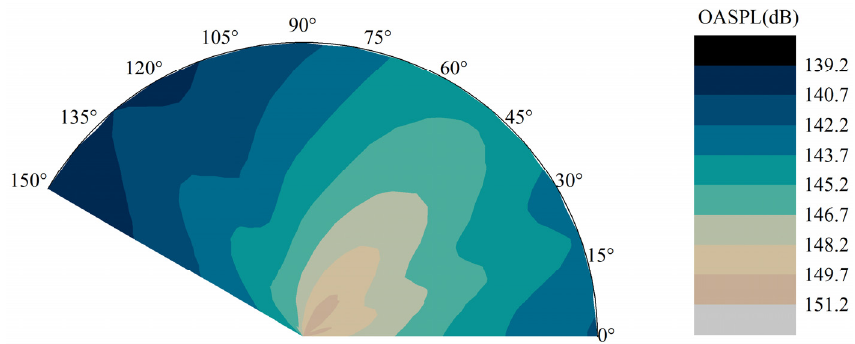
Figure 12. Direction diagram of OASPL on Plane XZ.